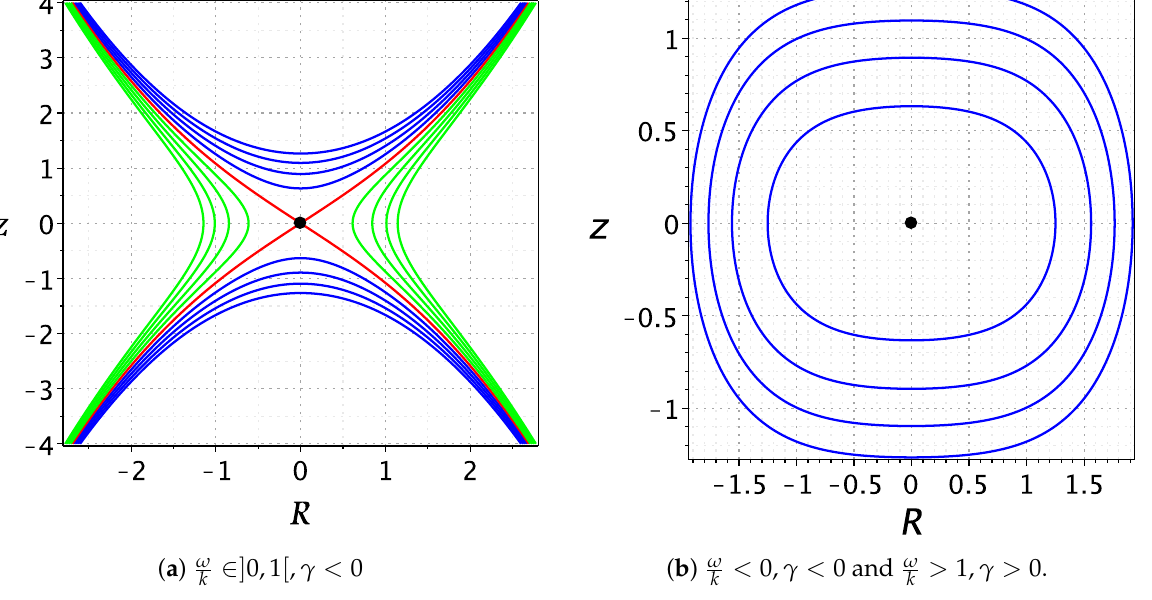
) γ < 0. The black solid circles indicate the k